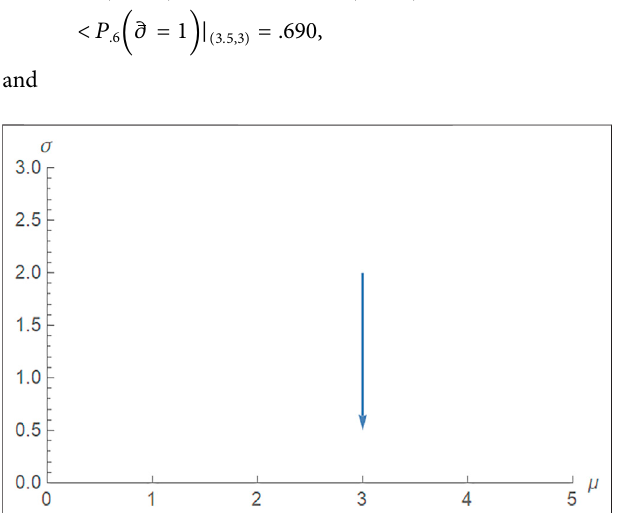
FIGURE 4 | Geodesic starting at p = (3, 2) and ending at q = (3,